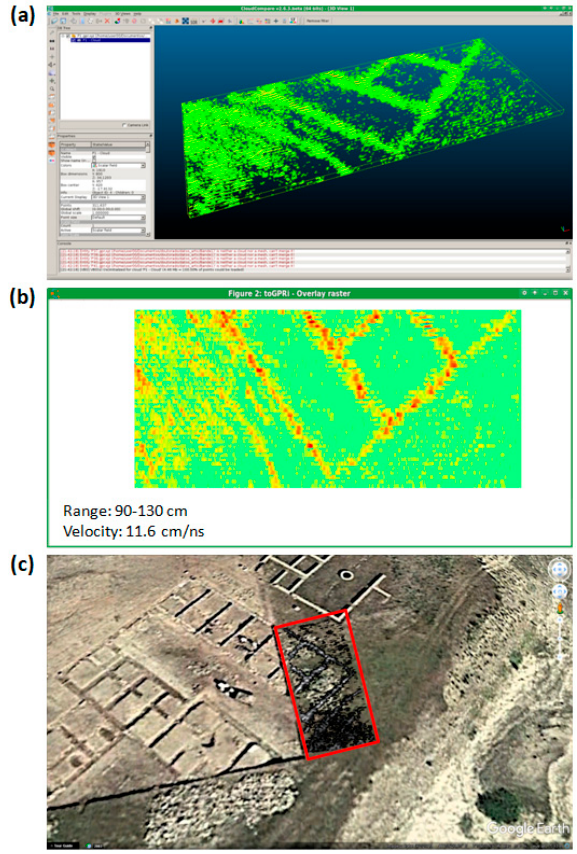
Figure 4 . Different GPR results obtained with the “toGPRi” tool: ( a ) visualization of a horizontal slice of the 3D GPR cube in a point cloud viewer; ( b ) raster image generated through the overlay of several time-slices and ( c ) superposition of the 3D overlaid image with the aerial photograph of the site in Google Earth viewer.